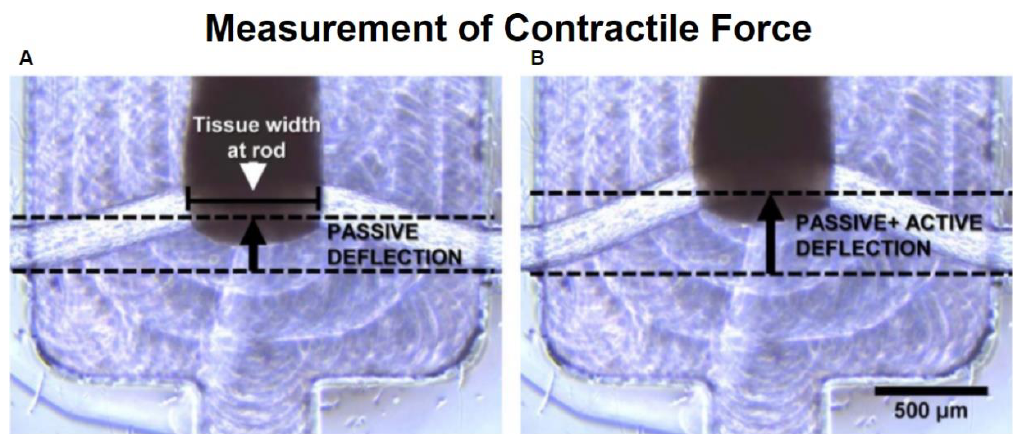
Figure 8. Measurement of pulsatile strength using a PDMS rod. By measuring the deflection at rest ( A ) against the deflection during stimulated contraction ( B ) the force exerted by the tissue can be measured. Adapted from Mastikhina et al. [31].